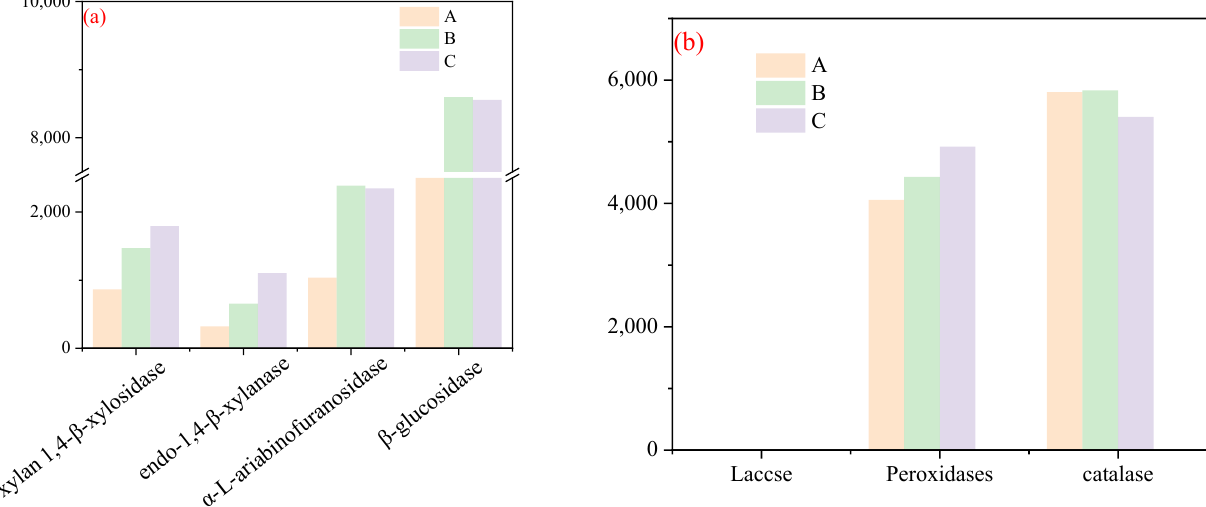
Figure 4. The abundance of associated enzymes predicted by PICRUSt. ( a ) Abundance of enzymes associated with hemicellulose degradation; ( b ) abundance of enzymes associated with lignin degradation. A, B and C denoted all samples collected on day 7d and 10d, in groups treated by microorganisms A, B and C.